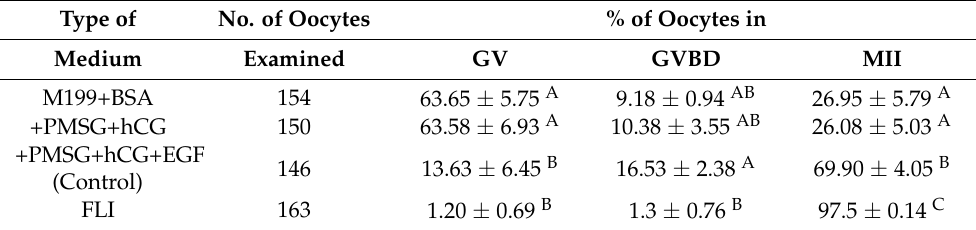
Table 1. Effect of gonadotropins, EGF and FLI cytokines on maturation of porcine oocytes in vitro. Type of No. of Oocytes % of Oocytes in Medium